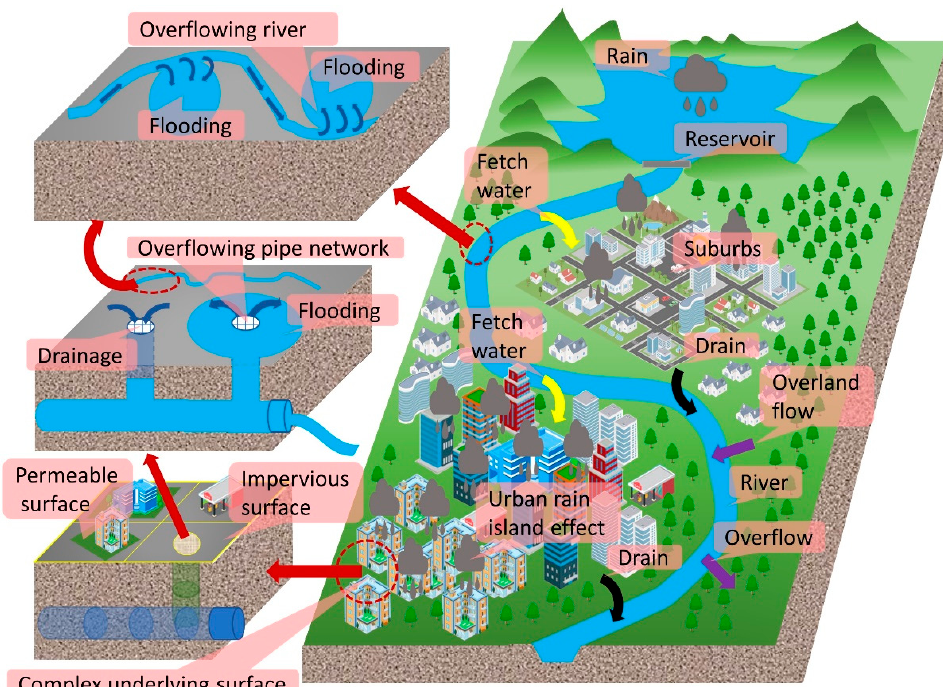
Figure 1. Schematic diagram of urban rain flood inundation principle. (Compared with natural watersheds, the underlying surface conditions of cities are more complicated. Urban floods also include three parts: pipe network overflow, river overflow, and surface overflow).